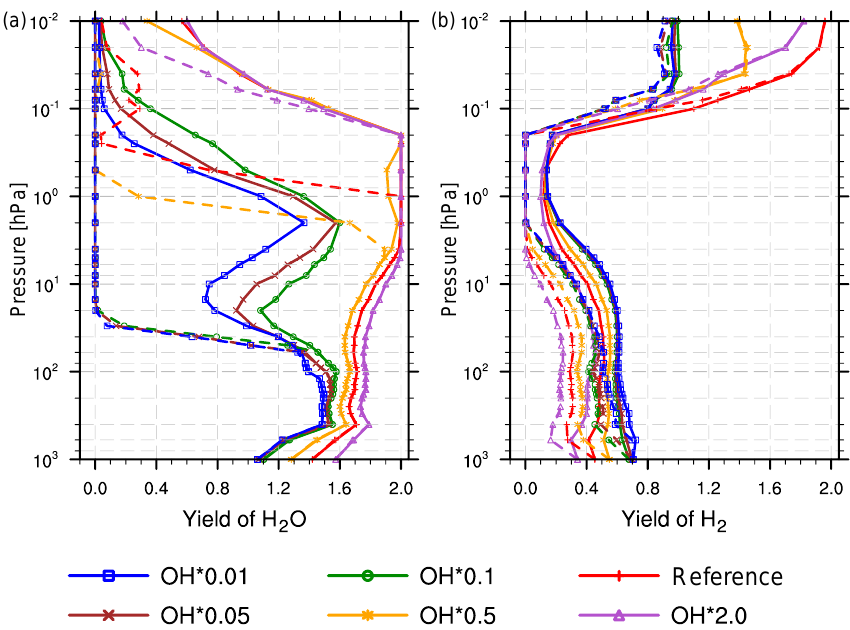
Figure 6. Pseudo-vertical profiles of the H 2 O yield (a) and H 2 yield (b) , calculated by the box model approach. Solid lines represent the direct yield, the dashed lines the effective yield and circles indicate the pressure levels of the model boxes. OH concentrations are prescribed in all simulations to the initial values of the respective vertical box. The plot shows simulations with the reference OH concentration (Ref, red, plus signs) as well as the OH concentration multiplied by 2 (SS5, purple, triangles), multiplied by 0.5 (SS1, orange, asterisks), multiplied by 0.1 (SS2, green, circles), multiplied by 0.05 (SS3, brown, crosses) and multiplied by 0.01 (SS4, blue,